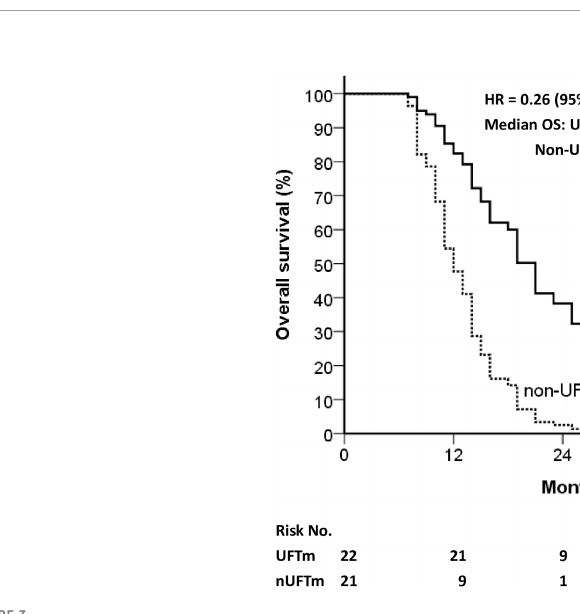
FIGURE 3 Overall survival of relapsed patients. CI , con fi dence interval; HR , hazard ratio; OS , overall survival; UFT , tegafur-uracil; UFTm , UFT